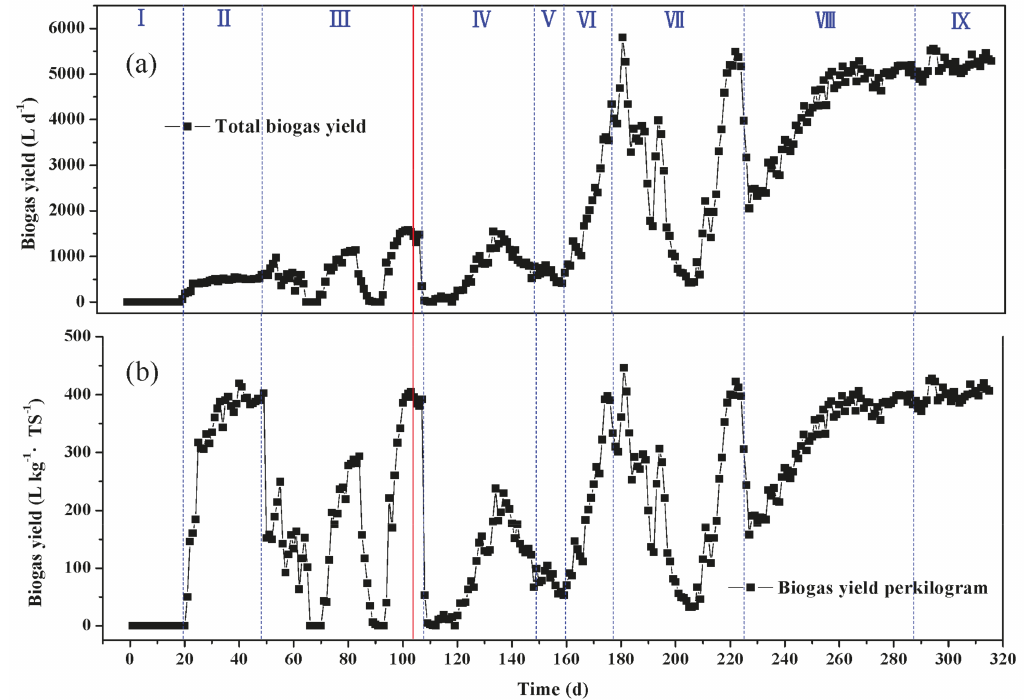
Figure 3. Biogas yield of the anaerobic digestion process in the pilot-scale test, ( a ) total biogas yield and ( b ) biogas yield per kilogram.